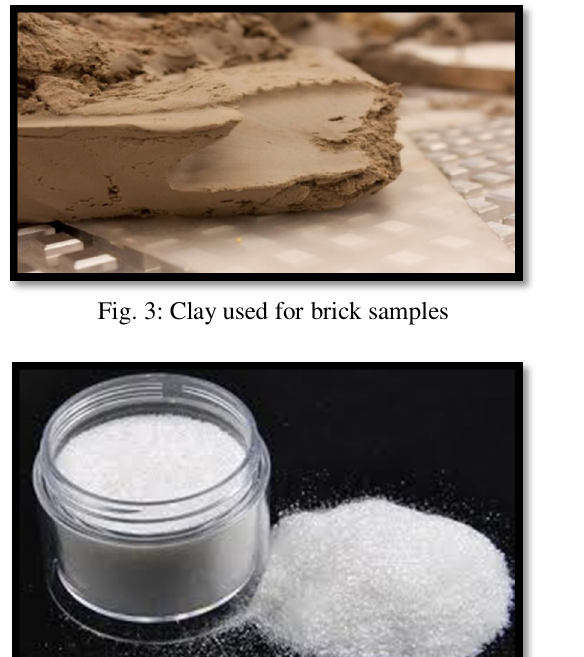
Table 1: Mix Design for Specimen Preparation